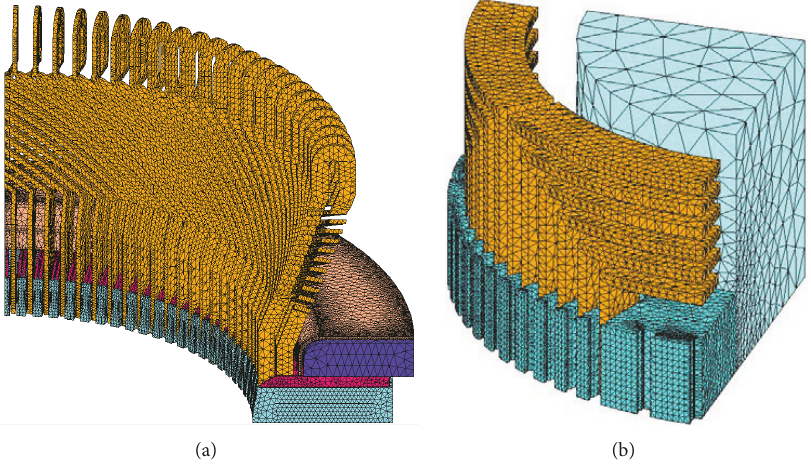
Figure 4: FE model mesh of the proposed generator end region. (a) Stator. (b) Rotor.